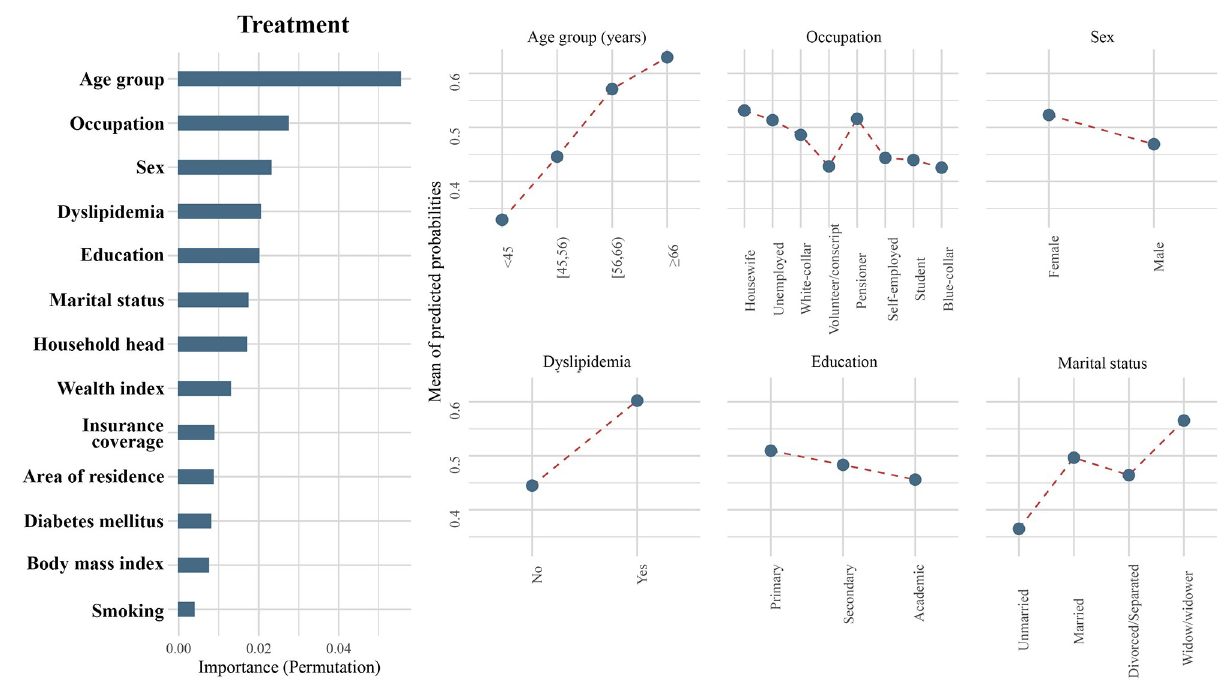
Fig 3. Importance of population characteristics and comparative probabilities of the top six important classifiers for treatment.